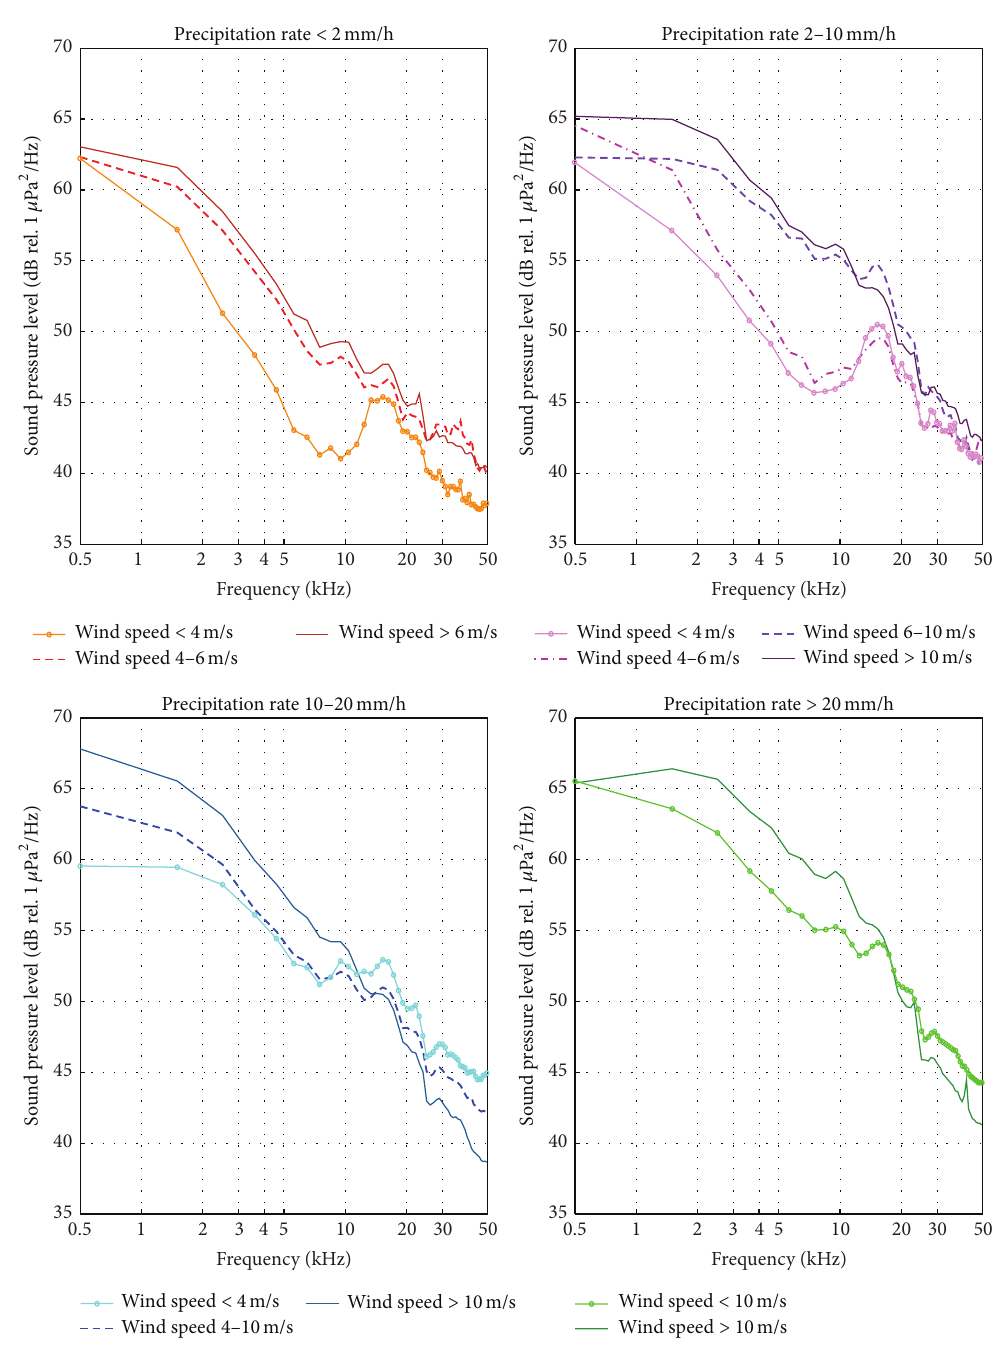
Figure 7: Average sound spectra at different rainfall rates (0–2, 2–10, and 10–20, over 20 mm/h) and wind speed categories as measured by instruments installed on board the